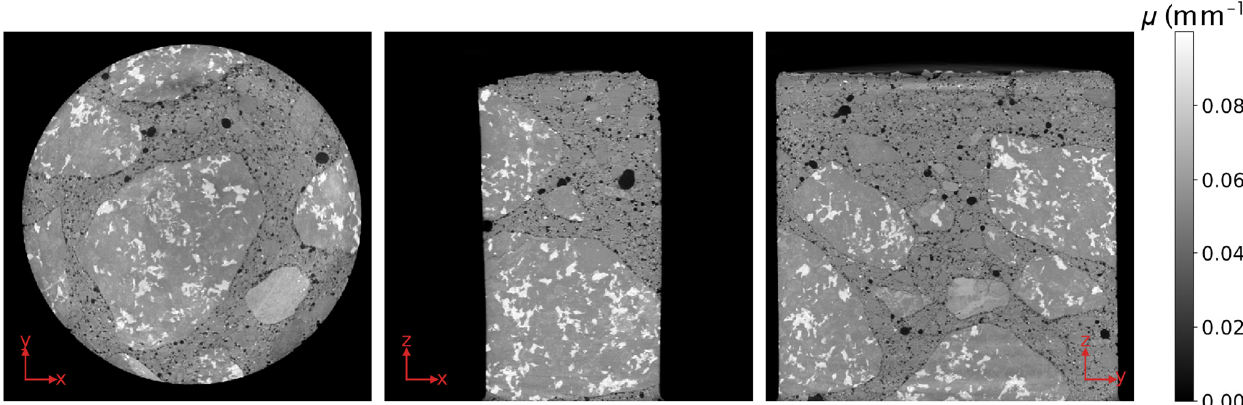
Figure 5. Final reconstruction of the concrete rod as computed by DIRECTT. The volume has the same size as the volume shown in Figure 1 through omission of its upper and lower slices. The position of the slices shown corresponds precisely to that of the slices in Figure 1.